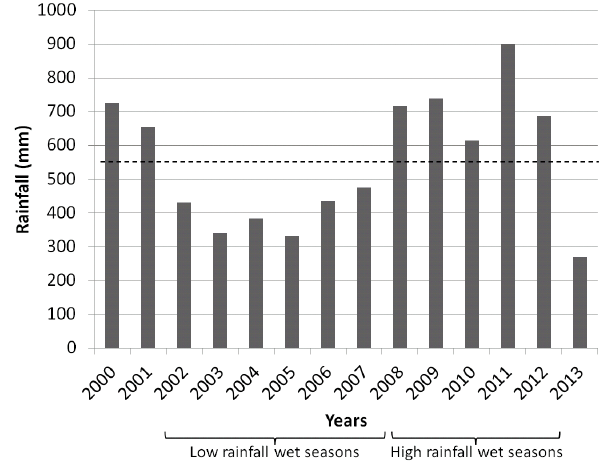
Figure 2. Annual average rainfall in BDT for 2000–2013. The dashed line is the 14-year